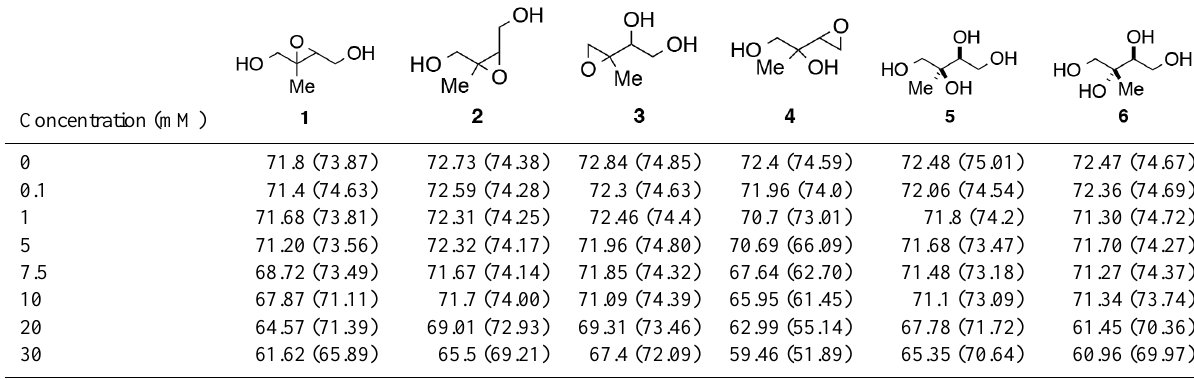
Table 1. Equilibrium surface tension (at t = ∞ ) for IEPOX (1–4) and 2-methyltetraols (5, 6).